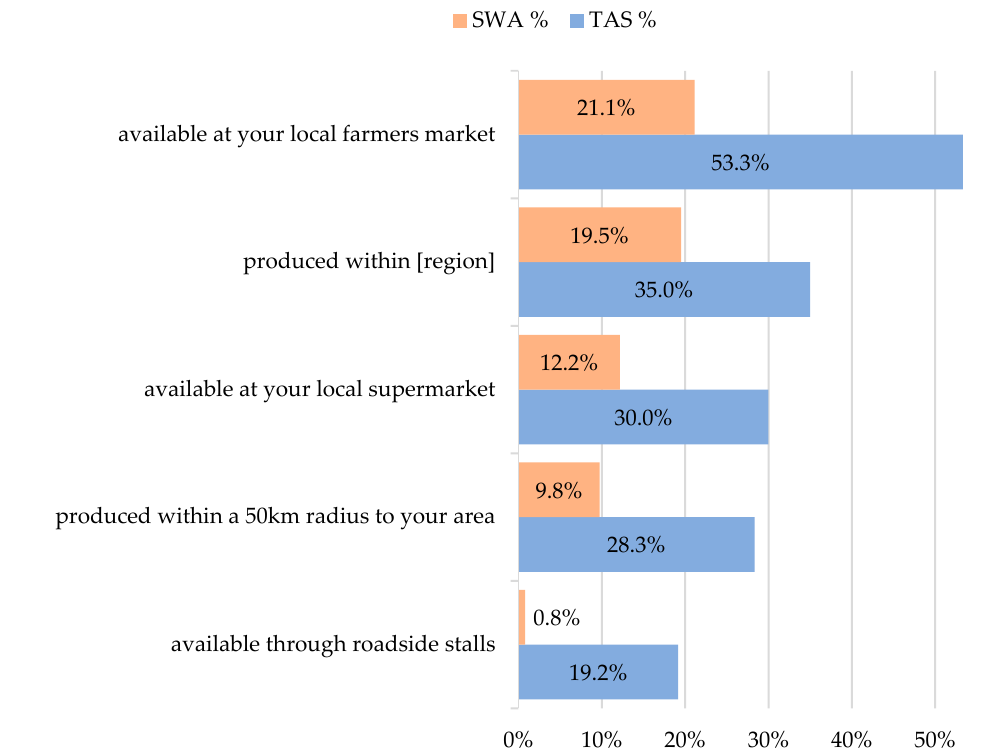
Table 2. Methods used to identify RGFFV in Tasmania and